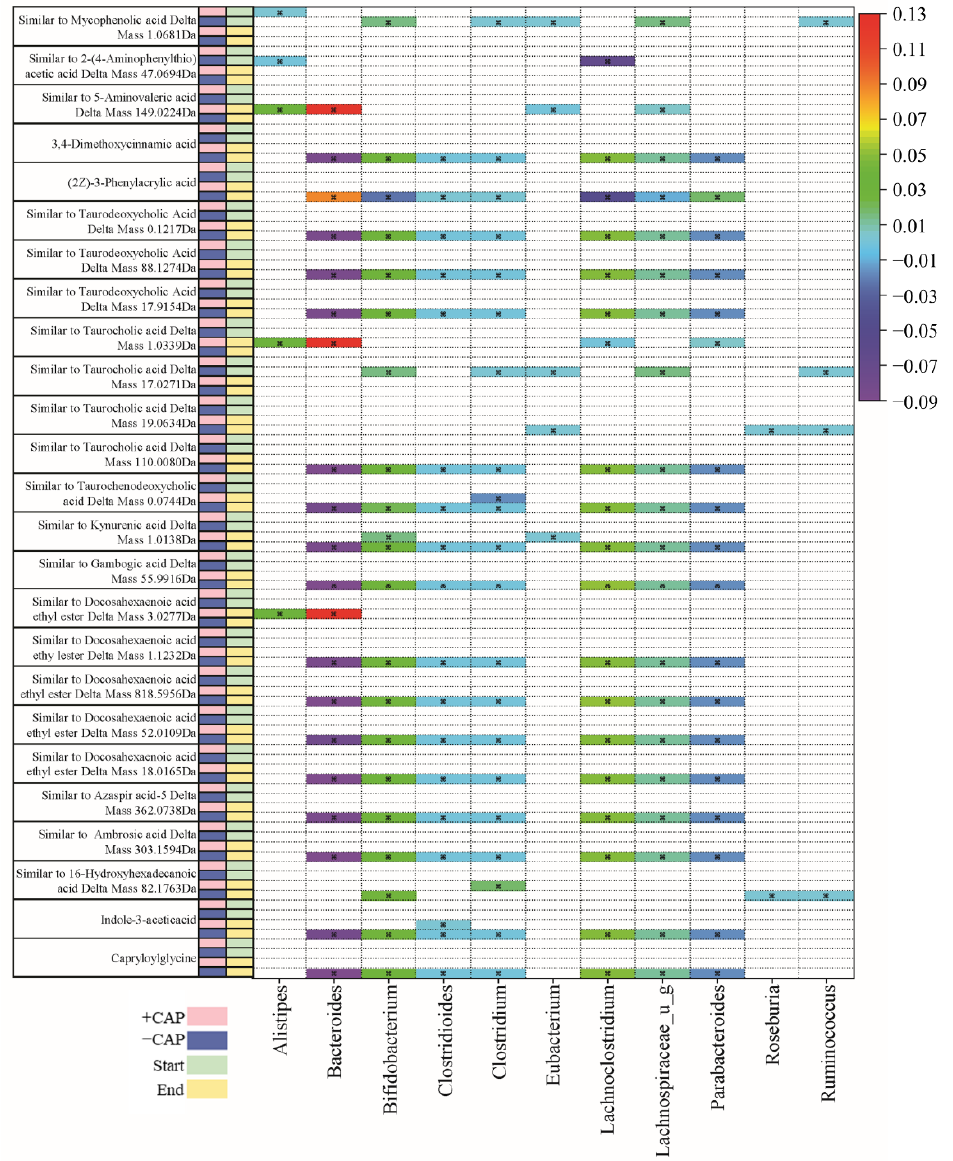
Figure 5. Table of C1 community correlations of metabolites to key bacterial species, from CAP Start to CAP End. Significant correlations were determined by q < 0.05.